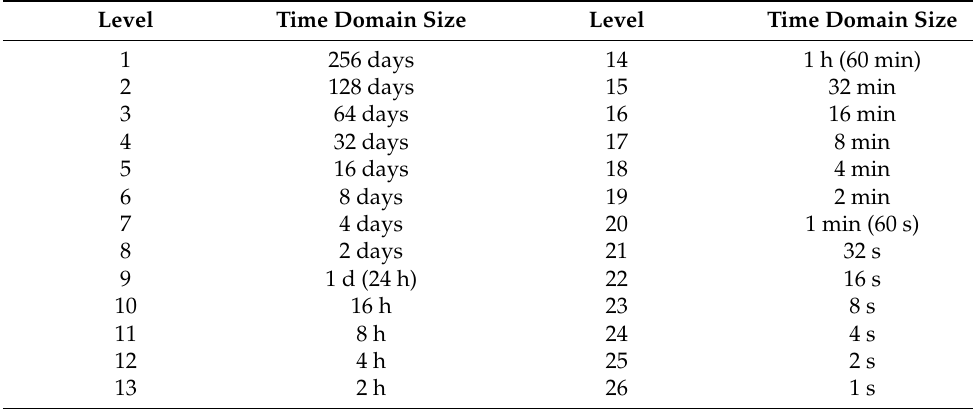
Table 2. Indoor time section hierarchy